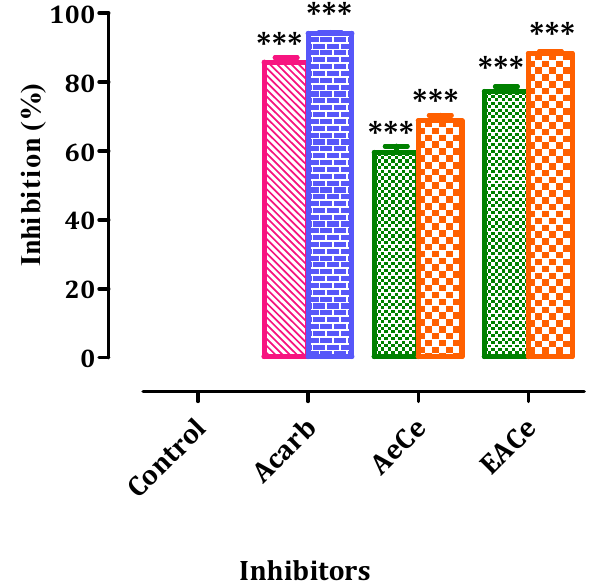
Figure 5. Inhibitory activity of the enzymes α -amylase by AeCe, EACe, and acarbose in vitro. The values are the means ± SEM ( n = 3). AeCe: Aqueous extract of C. europaea ; EACe: Ethyl acetate fraction of C. europaea . *** p < 0.001 compared to the control group .